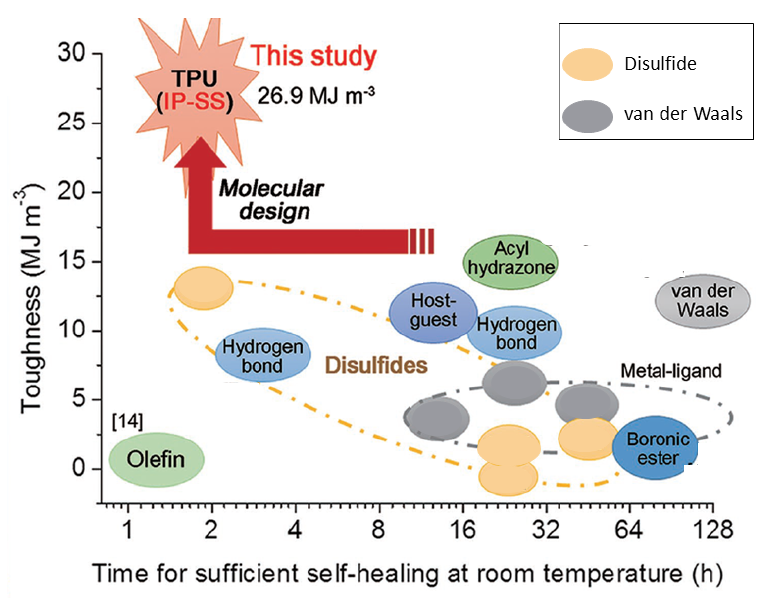
Figure 36. Ashby plot of self-healing time at room temperature versus toughness. Adapted with permission from [13]. Copyright (2017) Wiley Periodicals, Inc.